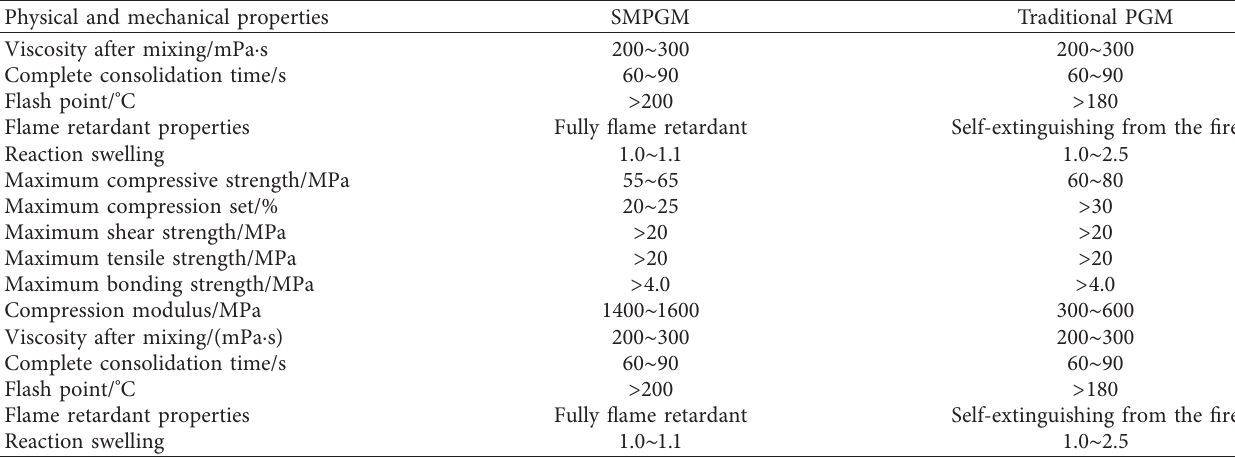
Figure 9: Distribution characteristics of axial pore pressure. (a) 4MPa. (b) 6MPa. (c) 8 MPa. (d) 10MPa. Table 1: Comparison of physical properties between SMPGM and traditional